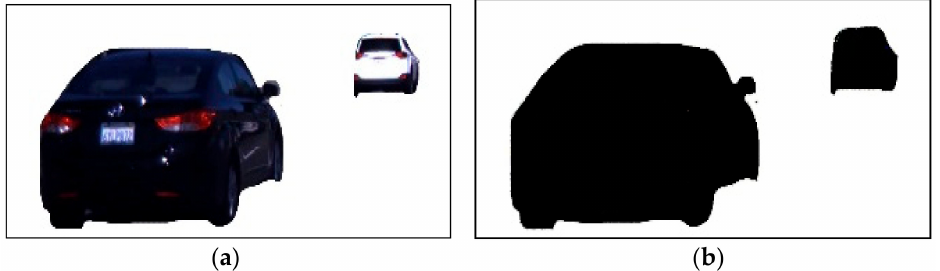
Figure 4. Example results of object shape optimization: ( a ) background-subtracted image and ( b ) optimized shape in binary